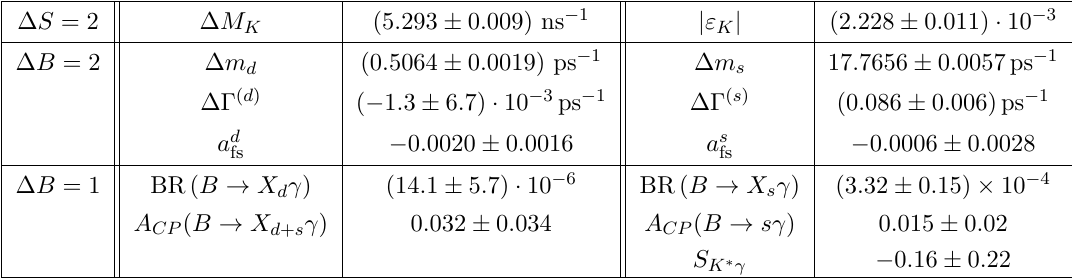
Table 1 . Experimental input for the processes discussed in section 5.3 and for the ∆ B = 1 processes discussed in appendix D.2 [119, 133, 134]. The branching ratios BR ( B → X photon energy, E 1 . 6 γ >